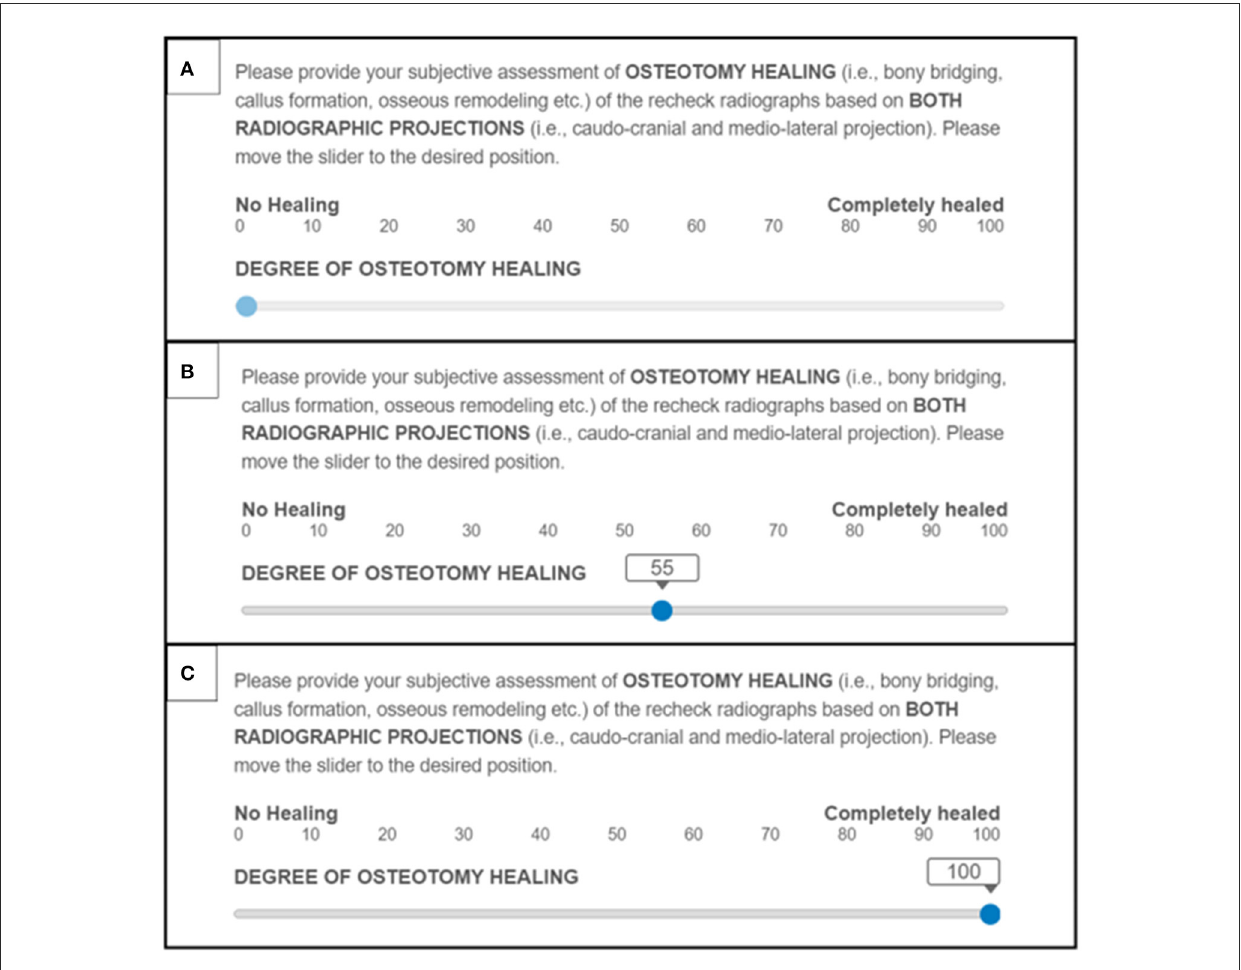
FIGURE3 Examples of the Visual Analog assessment score system used to grade TPLO osteotomy healing: (A) Slider placement representing 0% healed. (B) Slider placement representing 55% healed. (C) Slider placement representing 100% healed.